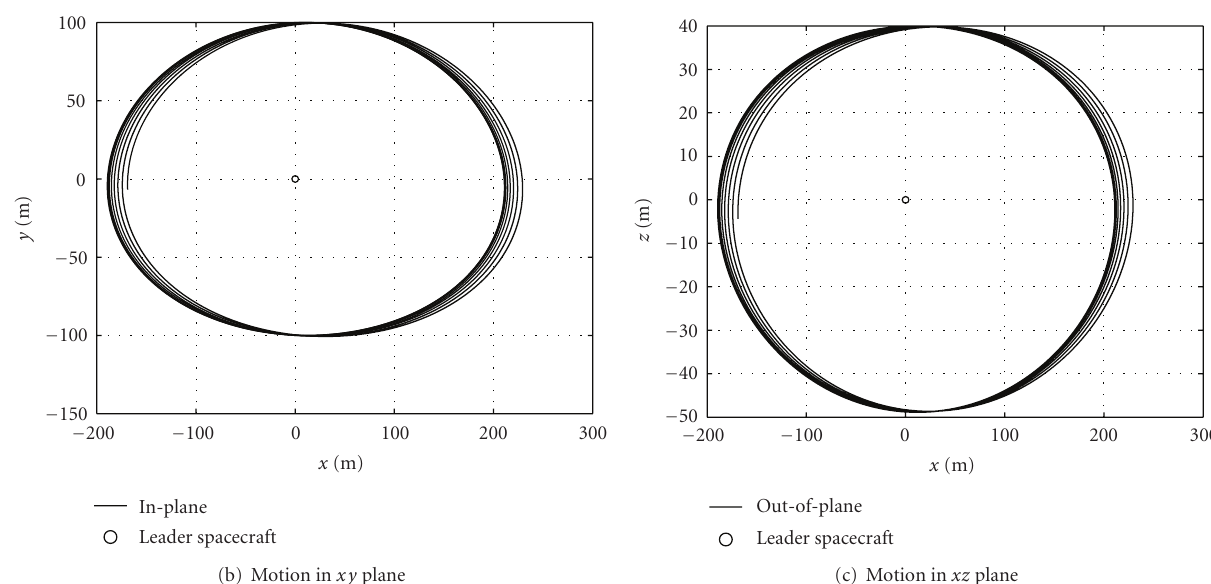
Figure 2: Relative motion of spacecraft in formation with J 2 perturbation and initial o ff